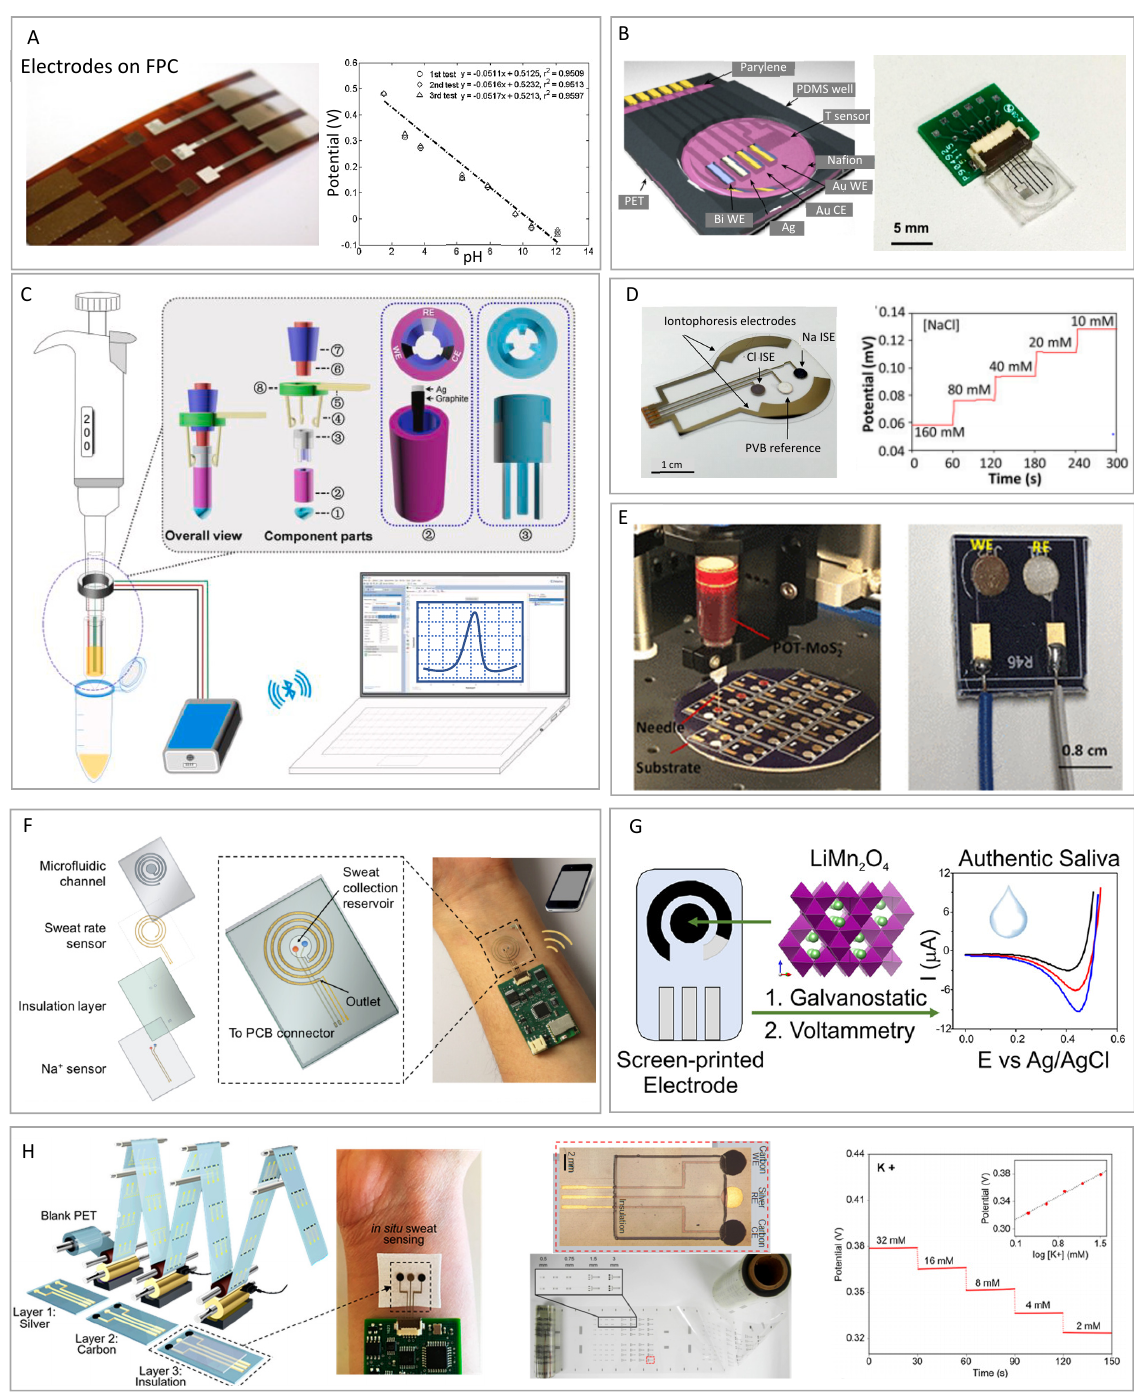
Figure 2. ( A ) From left to right, shows a fabricated device containing three pairs of electrodes and pH sensitivity on a flexible printed circuit (FPC) board. Reproduced with permission. Copyright 2011, Elsevier [38]. ( B ) From left to right, schematic showing a printed circuit board (PCB) connector interfacing with a multiplexed microsensor array with working electrode (WE) and counter electrode (CE) on a polyethylene terephthalate (PET) platform. The entire device can be covered with a polydimethylsiloxane (PDMS) material to create a well for sweat collection. Reproduced with permission. Copyright 2016, American Chemical Society [40]. ( C ) Schematic diagram of a tip-shaped sensor system: 1. conical nozzle, 2. electrode tube with three electrode strips, 3. connector, 4. connect the electrode, 5. platinum cable of the potentiostat, 6. pipette nozzle, 7. outer sleeve, 8. the sleeve fixes the cable on the pipette. Reproduced with permission. Copyright 2021, Elsevier [41]. ( D )